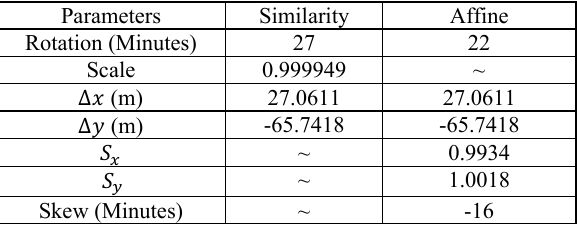
Table 1: The similarity and affine transformation parameters for the geo-location of the re-drawn map based on the historical field sheets.